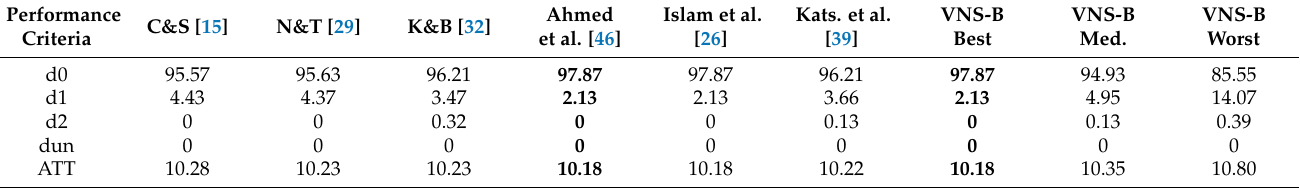
Table 3. Comparison of the final solution generated between methods for 6-Route